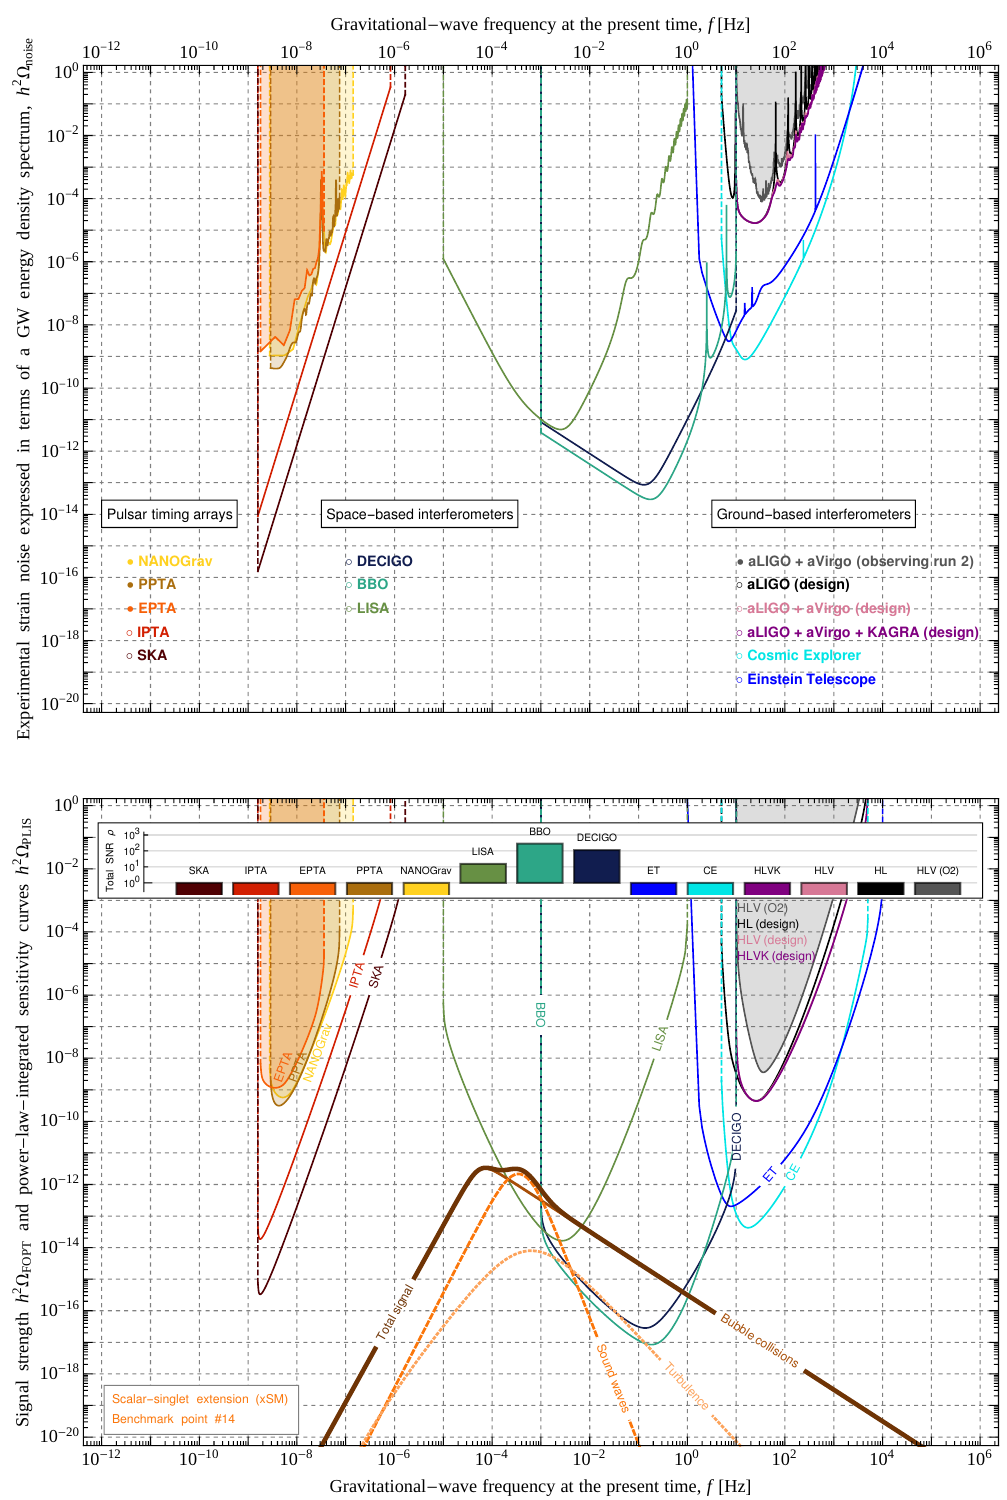
Figure 1 . Top: strain noise spectra. Bottom: PLISCs and GW signal for BP #14. See